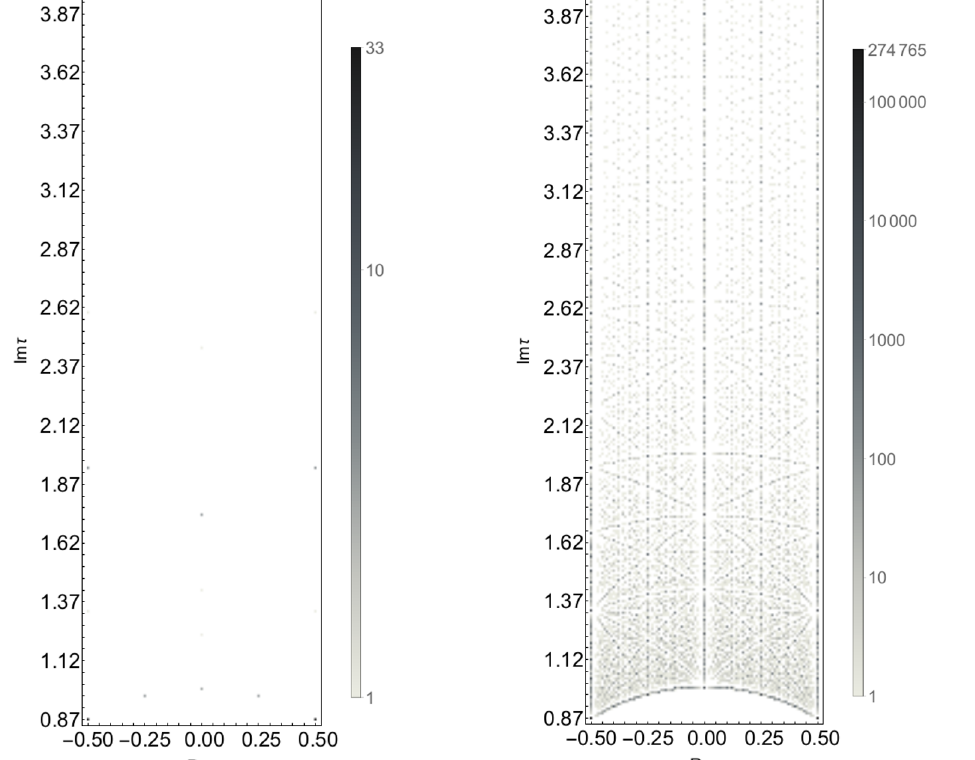
= 10 in the left panel and (cid:13)ux